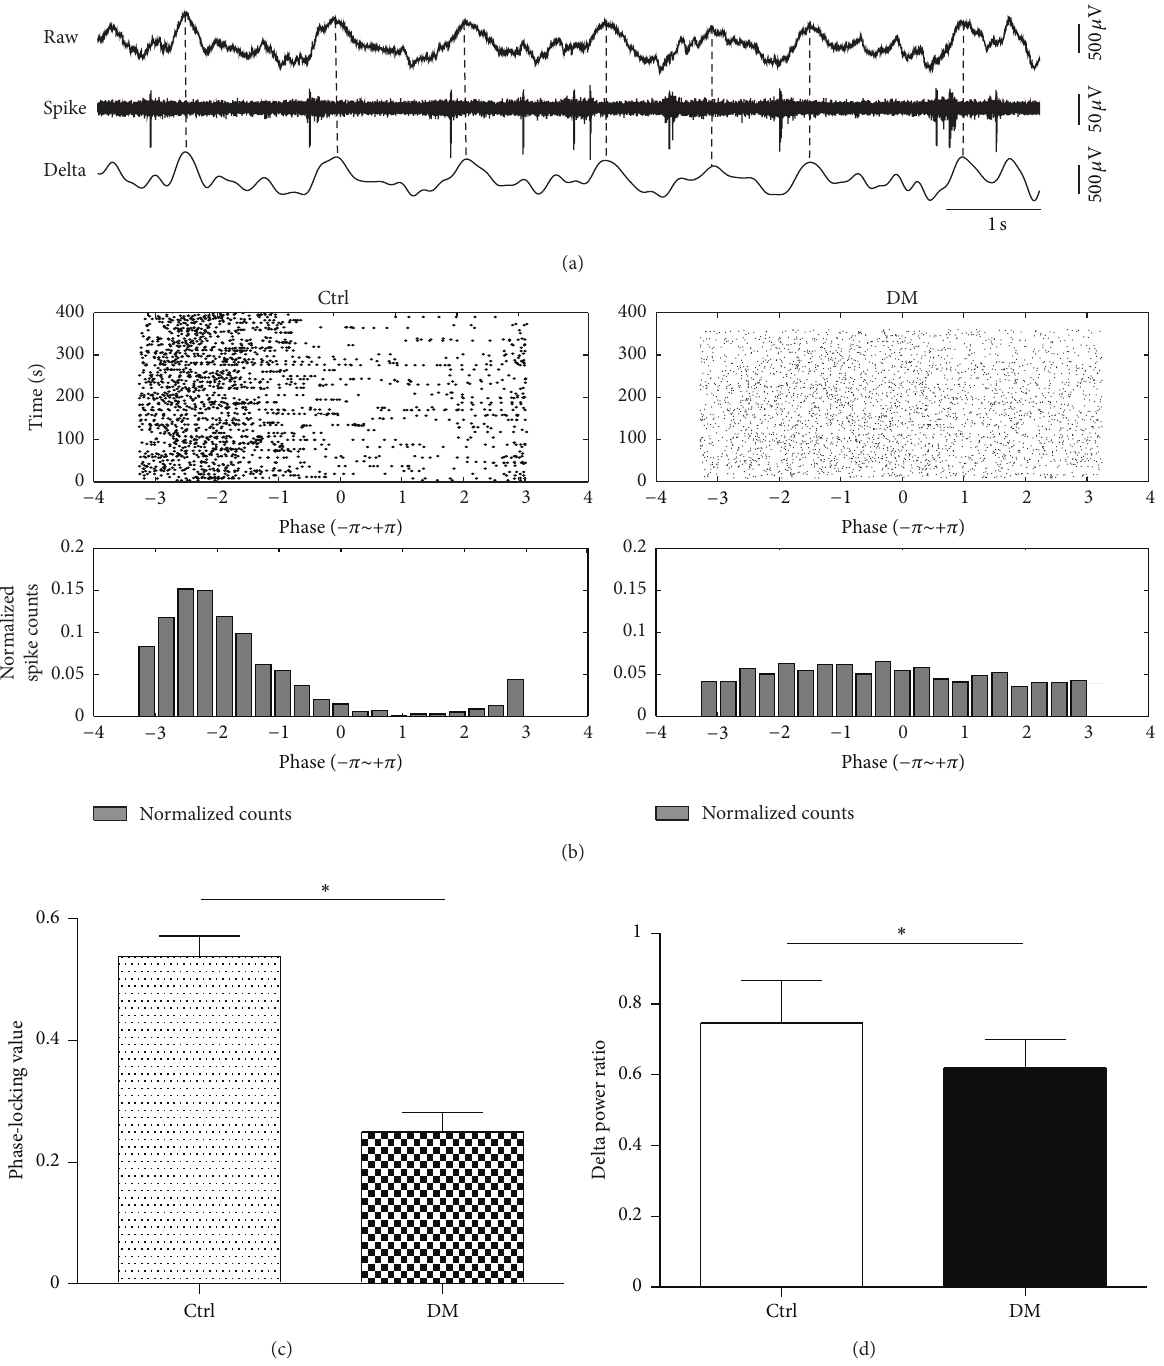
Figure 6: Phase-locking of hippocampal neurons. (a) Epoch of wide-band raw trace as well as corresponding delta oscillation of LFP (band- pass filtered in the frequency band of 1–4Hz) and spike train. The phase-locking between spike and delta oscillation of LFP is apparent. (b) Phase value rasters (upper panel) and the corresponding phase value (lower panel) distributions of two typical neurons in the control and DM groups. Control rats showed stronger phase-locking phenomenon than diabetic rats. (c) Comparison of phase-locking values between diabetic and control rats. The PLV in control rats (𝑛 = 59) was significantly higher than that in diabetic rats ( 𝑛 = 26 ) ( 𝑃 < 0.05 , Student’s 𝑡 -test). (d) Comparison of delta power ratio between Ctrl and DM groups. There was significant difference between Ctrl ( 𝑁 = 6 ) and DM ( 𝑁 = 6 ) groups ( 𝑃 < 0.05 , Student’s 𝑡 -test). “ 𝑁 ” represents number of rats and “ n ” represents number of